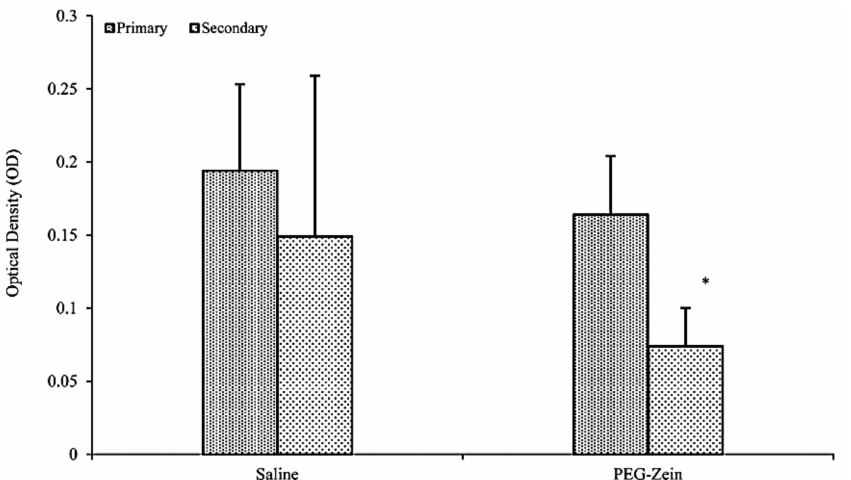
Figure 12. Antizein antibody levels after subcutaneous administration of mPEG − zein micelles in mice. The optical density of antizein antibodies in serum was measured after the third week of the first dose and the booster doses respectively. The results are represented as mean ± standard error of mean ( n = 4). mPEG − zein micelles did not produce any antizein antibodies, and the values were similar to those of the saline control (* p > 0.05). Reproduced with permission from [13], American Chemical Society,